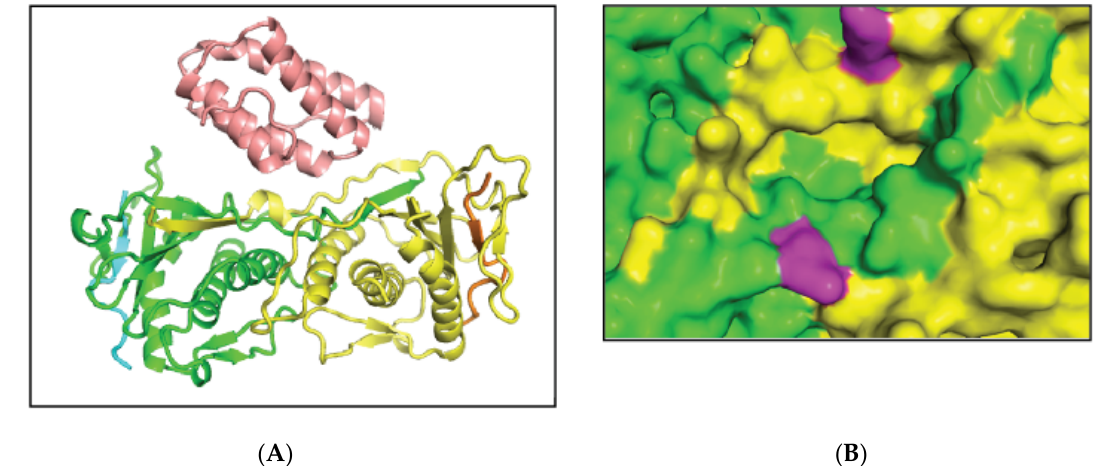
Figure 1 . MAD2L2 dimer in complex with a CAMP fragment and Rev1. ( A ) MAD2L2 proteins are shown in cartoon representation: MAD2L2 (yellow and green), CAMP fragment (orange and cyan) and Rev1 (Pink). ( B ) Surface representation of the cavity between the MAD2L2 monomers after binding Rev1. MAD2L2 monomers are colored yellow and green, and K190 of each monomer is colored magenta.